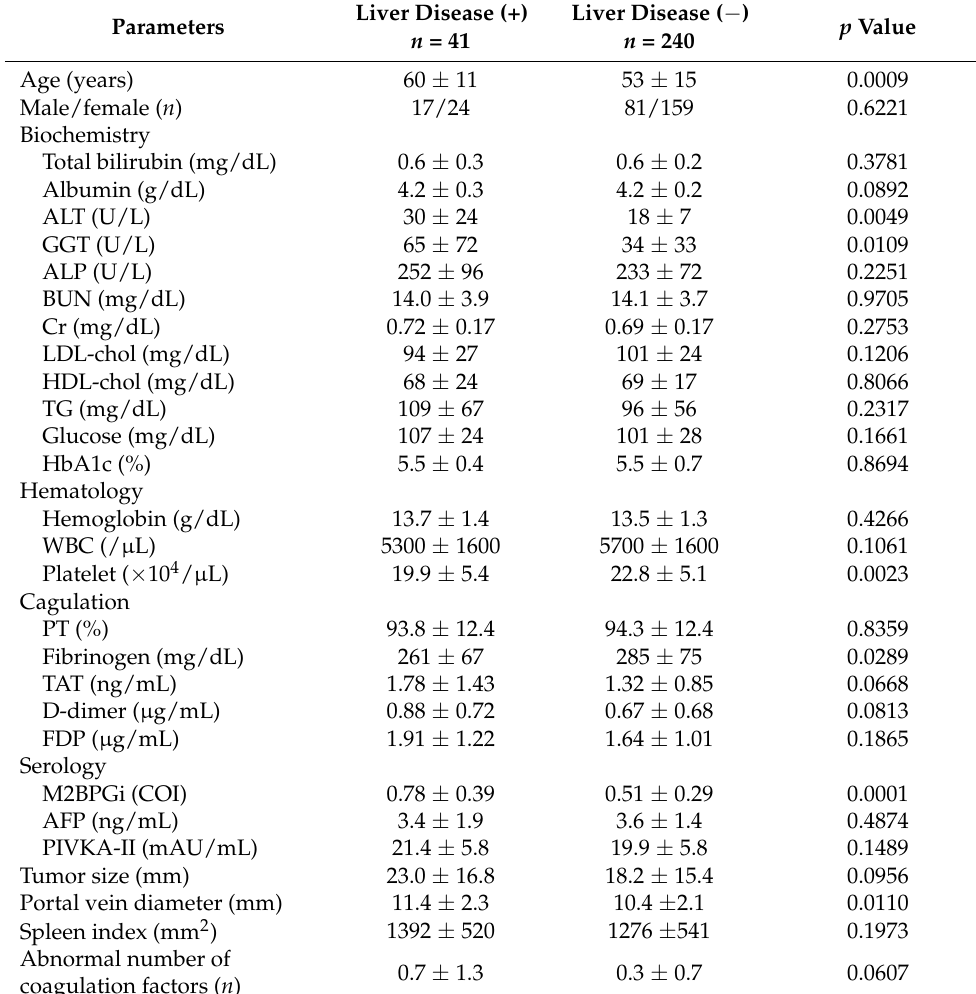
Table 7. Comparison of clinical parameters in patients with and without chronic liver disease as an underlying